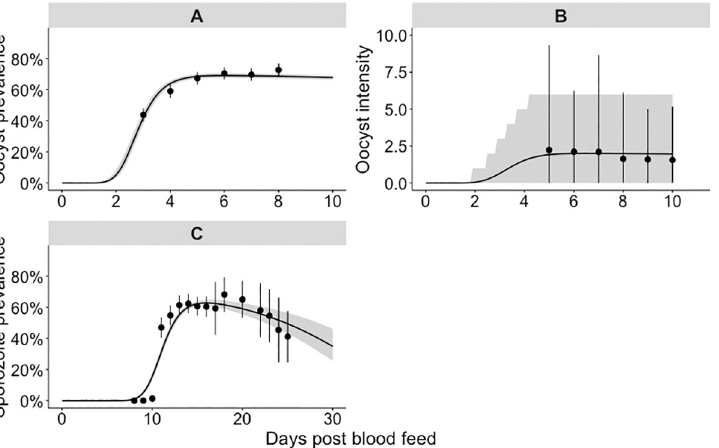
Fig 2. Single temperature 27˚C model fit to the oocyst and sporozoite data. The panels show our model fit to the 27˚C dataset: panel A to the oocyst prevalence, panel B to the oocyst intensity data and panel C to the sporozoite prevalence. (A & C) points show parasite prevalence of the laboratory mosquito data (95% confidence intervals are given by the point range). The grey shaded area represents the 95% credible interval of the model posterior predictive means, the median posterior predictive mean is shown by the black line. (B) The points show the mean parasite load among all blood fed mosquitoes (intensity); the point range indicates the 2.5%–97.5% quantiles of the raw data. The shaded area represents the 2.5%–97.5% quantiles of the negative binomial distribution; where the location and overdispersion parameters are set to their posterior